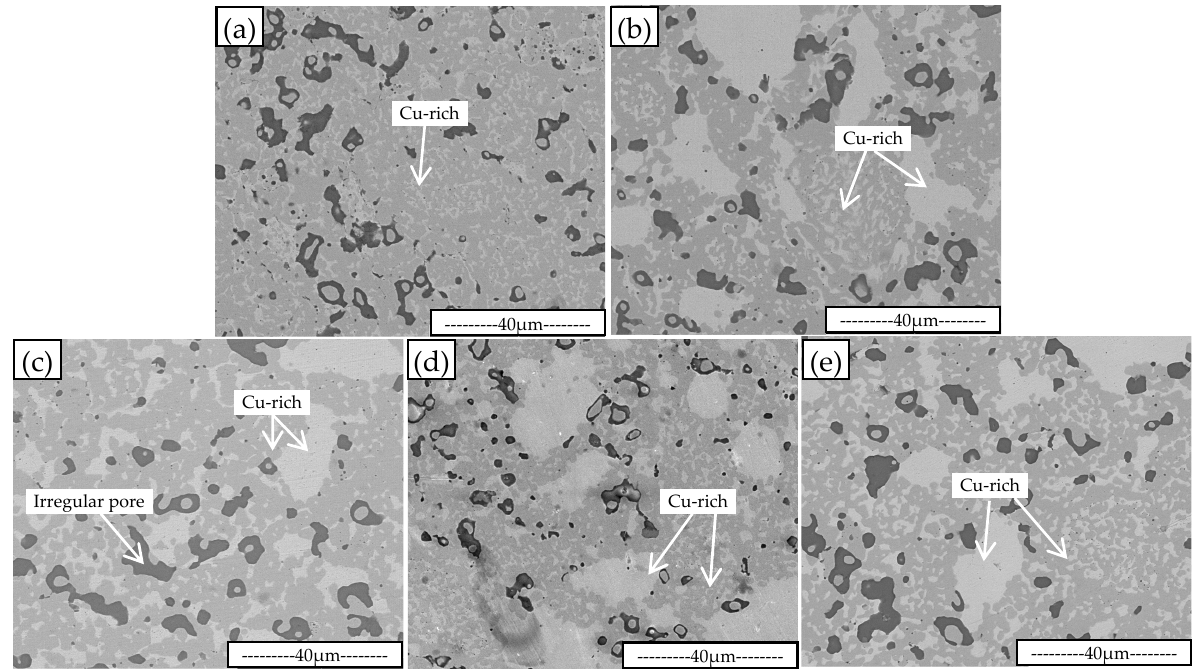
Figure 1. SEM metallographic pictures of sintered Fe-Cu-Co alloys without ( a ) and with 5 wt.% ( b ), 8 wt.% ( c ), 11 wt.% ( d ), 14 wt.% ( e ) Cu-Sn addition.